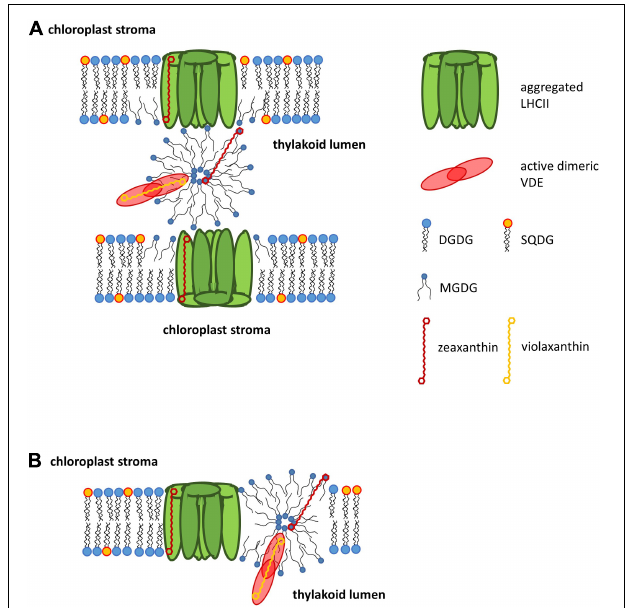
FIGURE 3 | Model for the violaxanthin cycle domain in thylakoid membranes of higher plants. High light illumination leads to a disconnection of the main light-harvesting complex of photosystem II, LHCII from the photosystem II core complex followed by protein aggregation. MGDG molecules, which during low light illumination surround the LHCII, dissociate, segregate and form a non-bilayer lipid phase. This non-bilayer lipid phase may be located outside of the membrane bilayer, i.e., within the thylakoid lumen (A) , or within the plane of the thylakoid membrane (B) . During high light illumination violaxanthin disconnects from its binding site at the LHCII apoproteins and diffuses into the non-bilayer lipid phase. The non-bilayer lipid phase represents an attraction site for the enzyme violaxanthin de-epoxidase (VDE), which, after its pH-dependent activation and dimerization, binds to the non-bilayer lipid phase. The non-bilayer lipid phase is characterized by a reduced surface tension and thus allows the penetration of the enzyme’s hydrophobic catalytic site into the hydrophobic core of the non-bilayer lipid phase where it gains access to the hydrophobic pigment violaxanthin. After the conversion of violaxanthin to zeaxanthin, zeaxanthin rebinds to the LHCII and participates in photoprotection via NPQ. Since the violaxanthin cycle domain, consisting of LHCII, MGDG, VDE and xanthophyll cycle pigments, is only established during high light illumination of plants, the domain can be described as a transient membrane